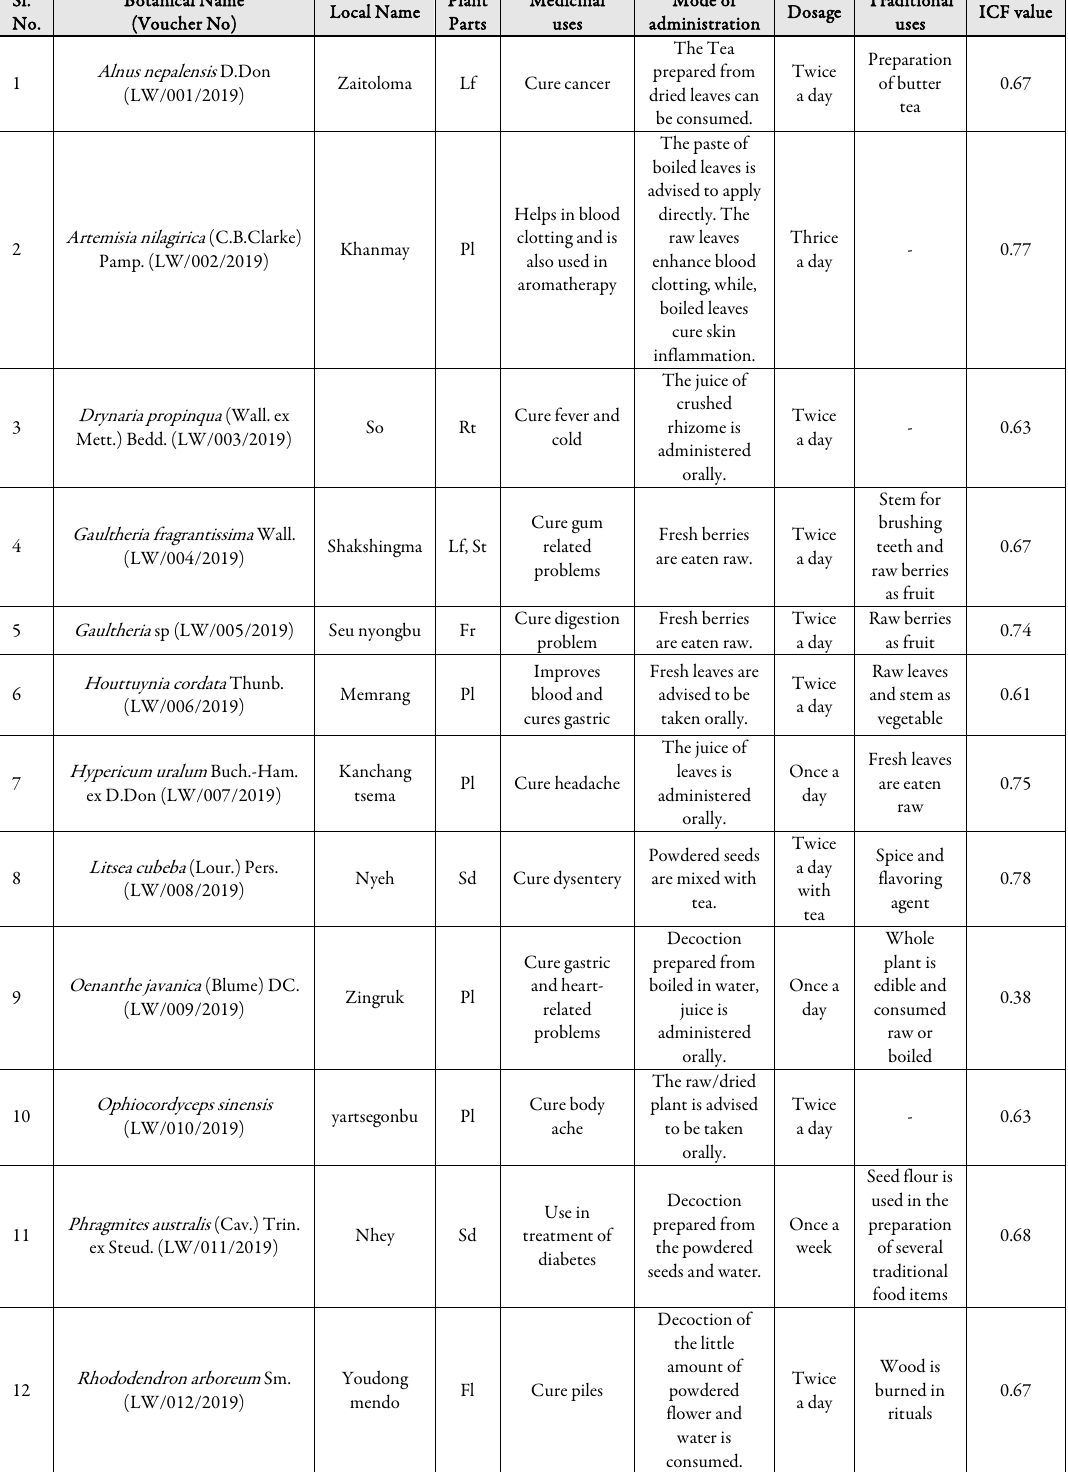
Table 2. Ethnomedicinal and other uses of collected medicinal plants of Dirang, Arunachal Pradesh Sl.